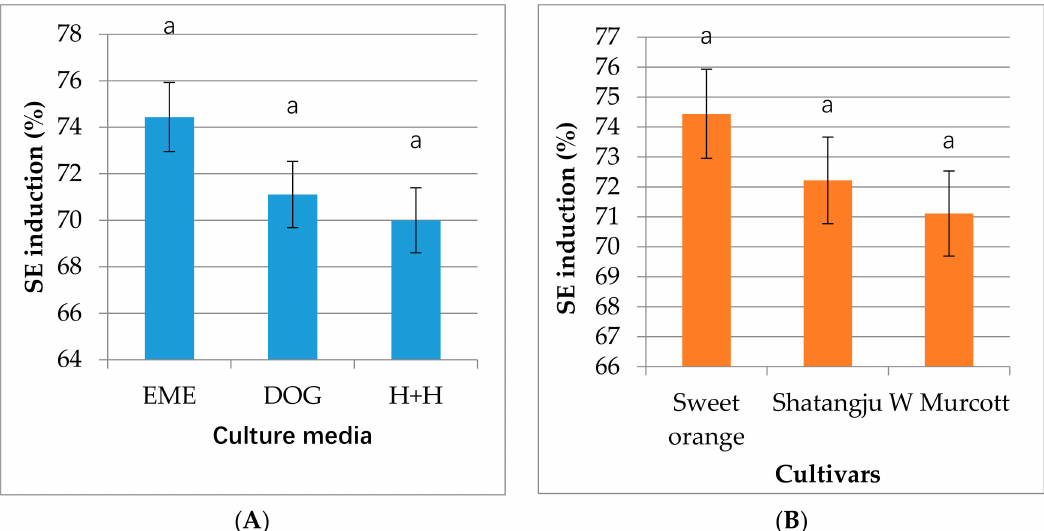
Figure 1. Somatic embryo induction.Data were recorded after 6–8 weeks of incubation. The statistical difference ( p ≤ 0.05) among the means was analyzed by Duncan’s multiplerange test using Statistical Package for the Social Sciences (SPSS- version 23), and results were expressed as mean ± standard error of three independent experiments. ( A ) Culture media effect, all explants on the individual medium were considered as one group irrespective of genotypes ( B ) Genotypes effect, all explants of the individual genotype on all three media were considered as one group.